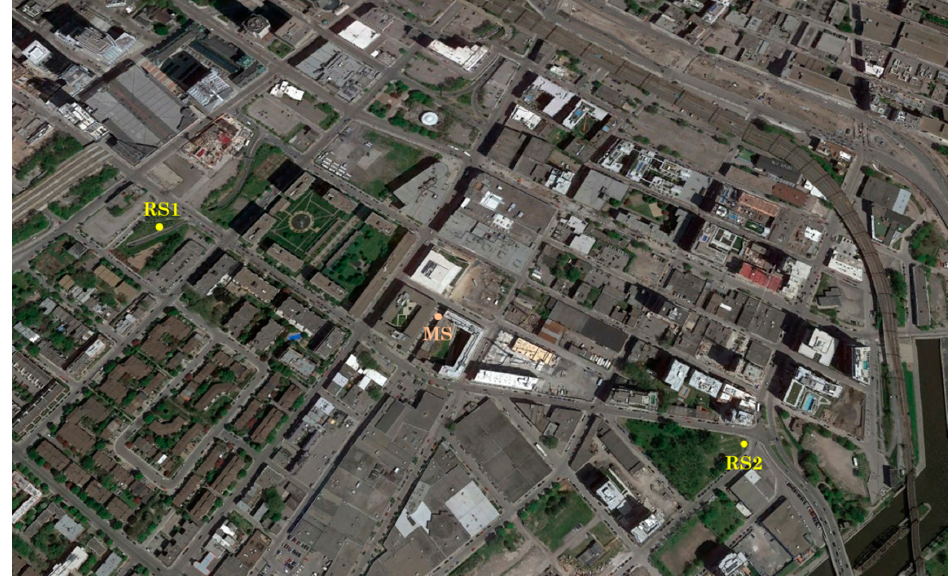
Figure 5. Position of MS and both RSs during satellite signals recording in downtown Montreal.